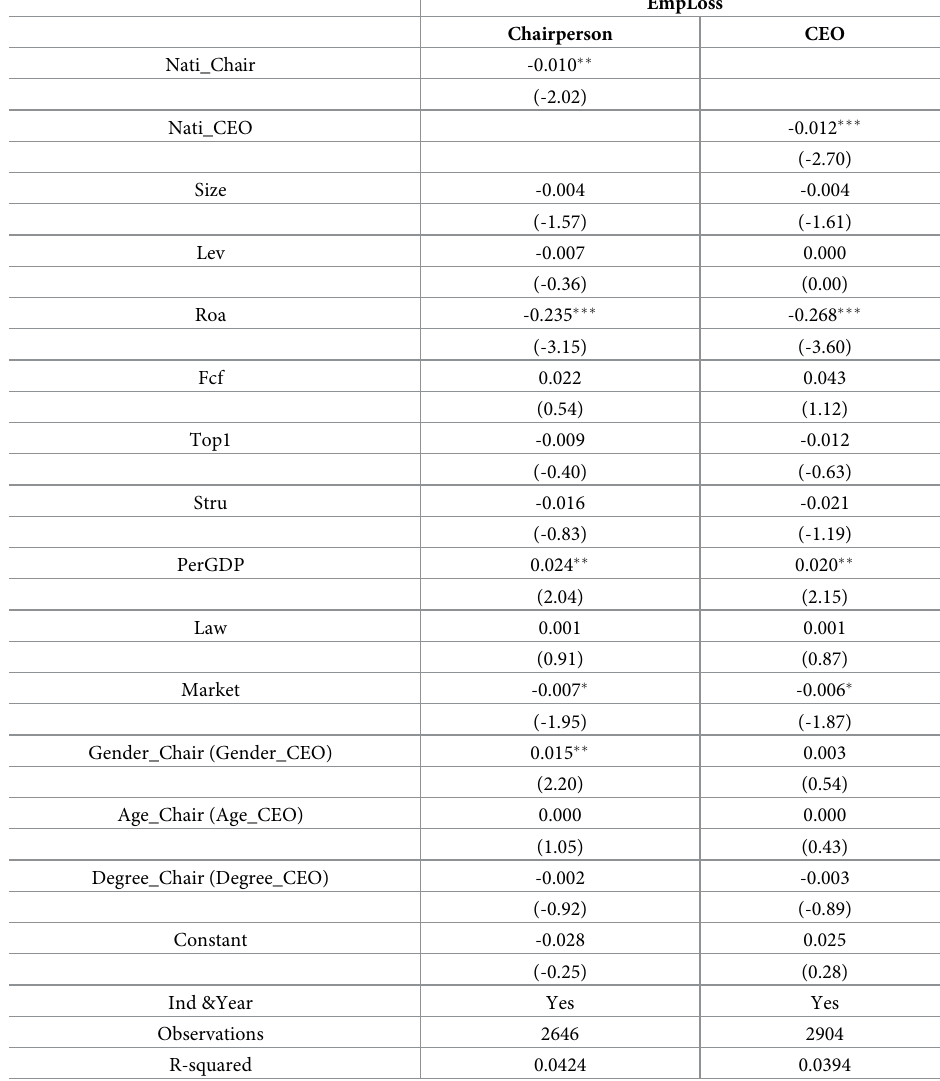
Table 9. Home bias of senior executives and employee turnover